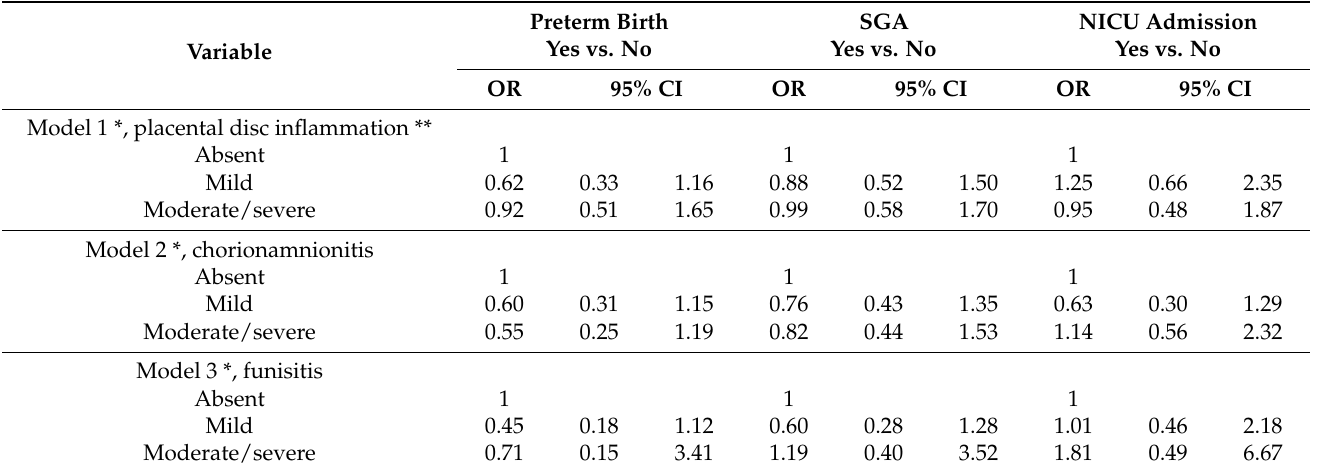
Table 3. Odds ratios of the occurrence of preterm births, small for gestational age, and neonatal intensive care unit admission—logistic regression